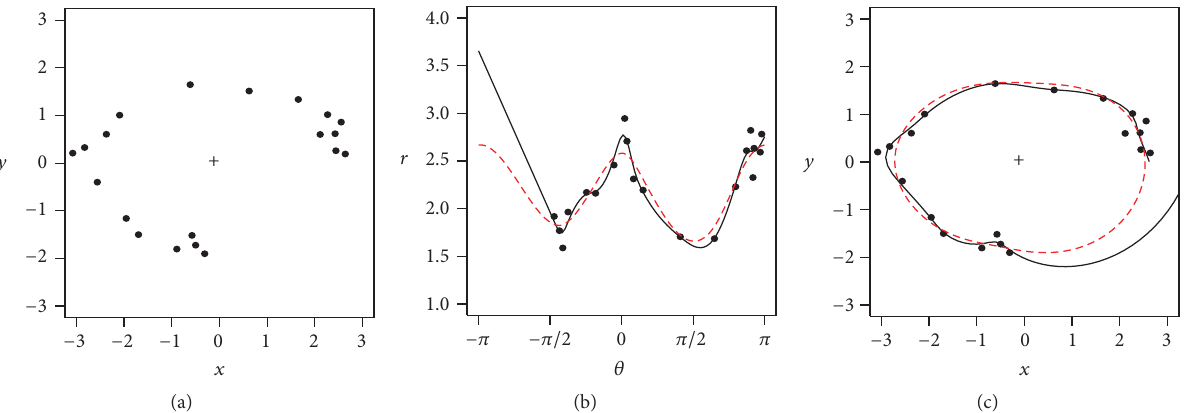
Figure 6: (a) Occluded data; (b) polar coordinate data with fitted spline curve; (c) data with back-transformed fitted curves. In (b) and (c) the solid curves use standard splines, whereas the dashed use the periodic